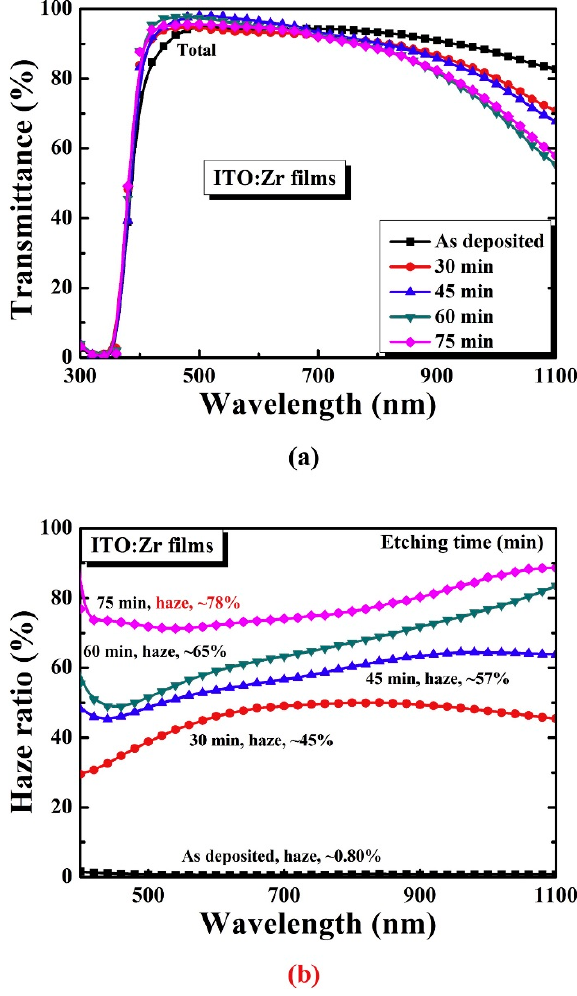
Figure 4. The optical characteristics ( a ) total transmittance, and ( b ) Haze ratio of ITO:Zr layers as a function of etching time. (Reprinted with permission from ref. [77]. Copyright form Elsevier order number—5492920078302).